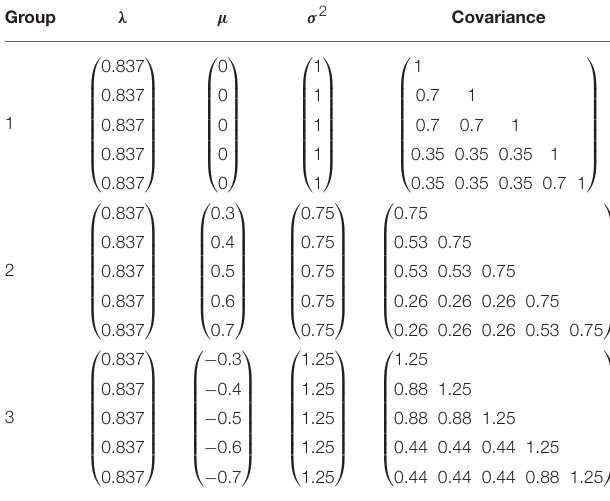
TABLE 1 | True parameter values of µ , λ , and σ 2 for the first-order traits θ ( d ) in the simulation study.